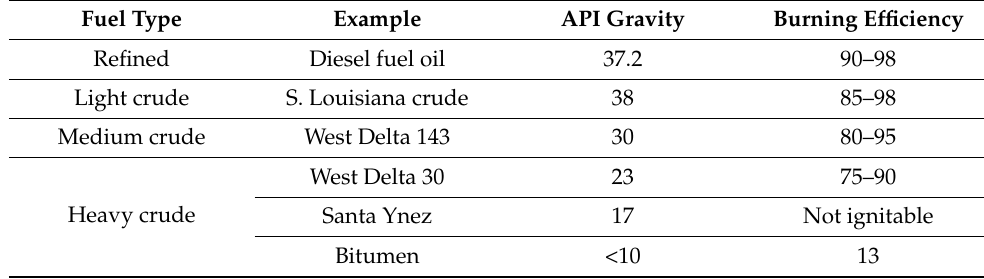
Table 5. The efficiency of in situ burning as a function of API gravity